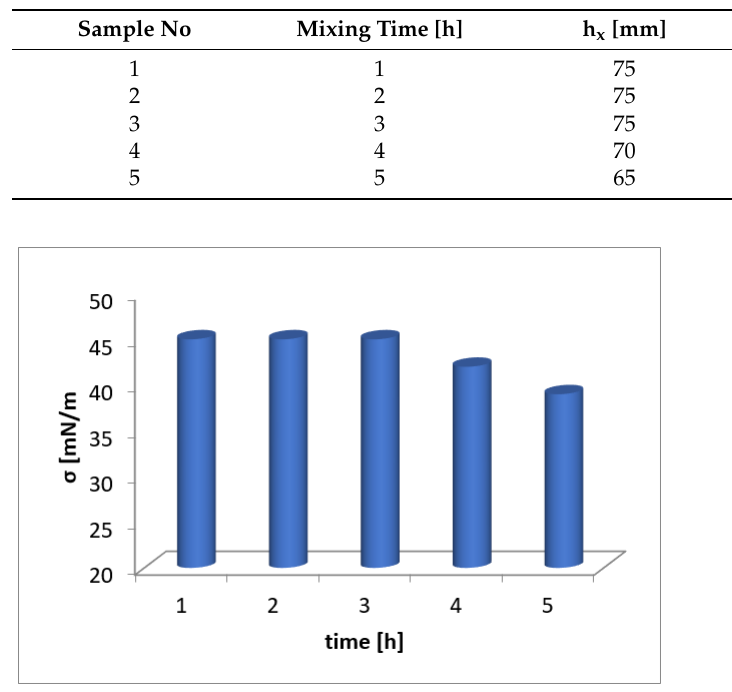
Figure 6. The variation of the surface tension versus mixing time of solutions containing washnut.